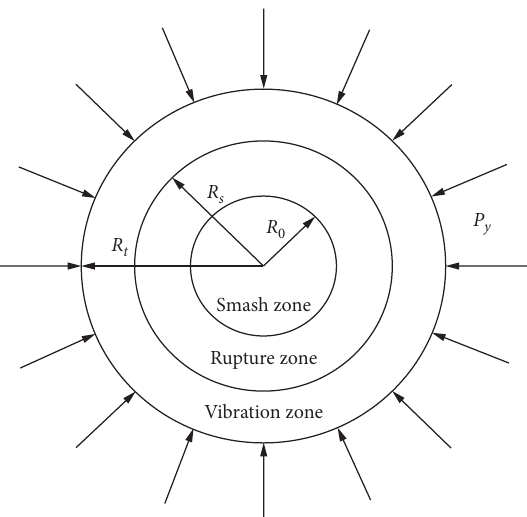
Figure 2: Mechanical model of the surrounding rock.